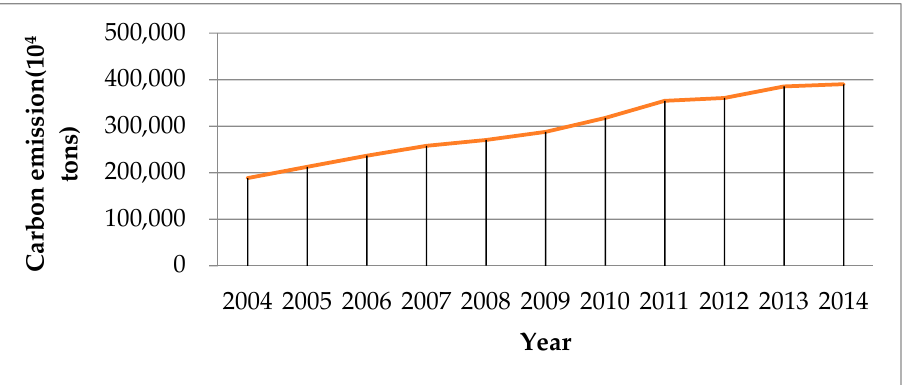
Figure 2. The total amount of carbon emissions from 2004 to 2014.